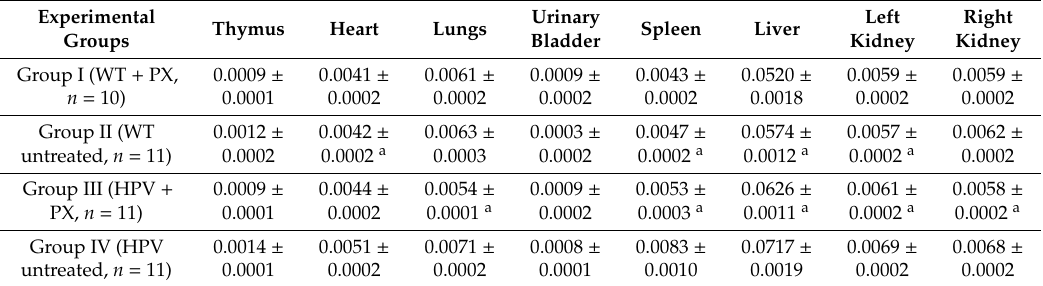
Table 1. Relative organ weights (mean ± standard